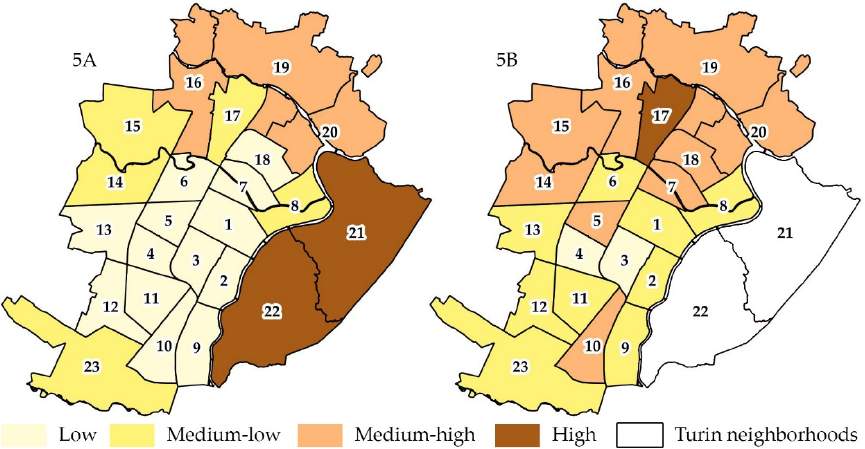
Figure 5. ( A ) Average values of the Provisioning and Regulating services of Turin neighborhoods—PAM; ( B ) Average values of S-AQI at the neighborhood scale; for neighborhoods 21 and 22 data are not available.